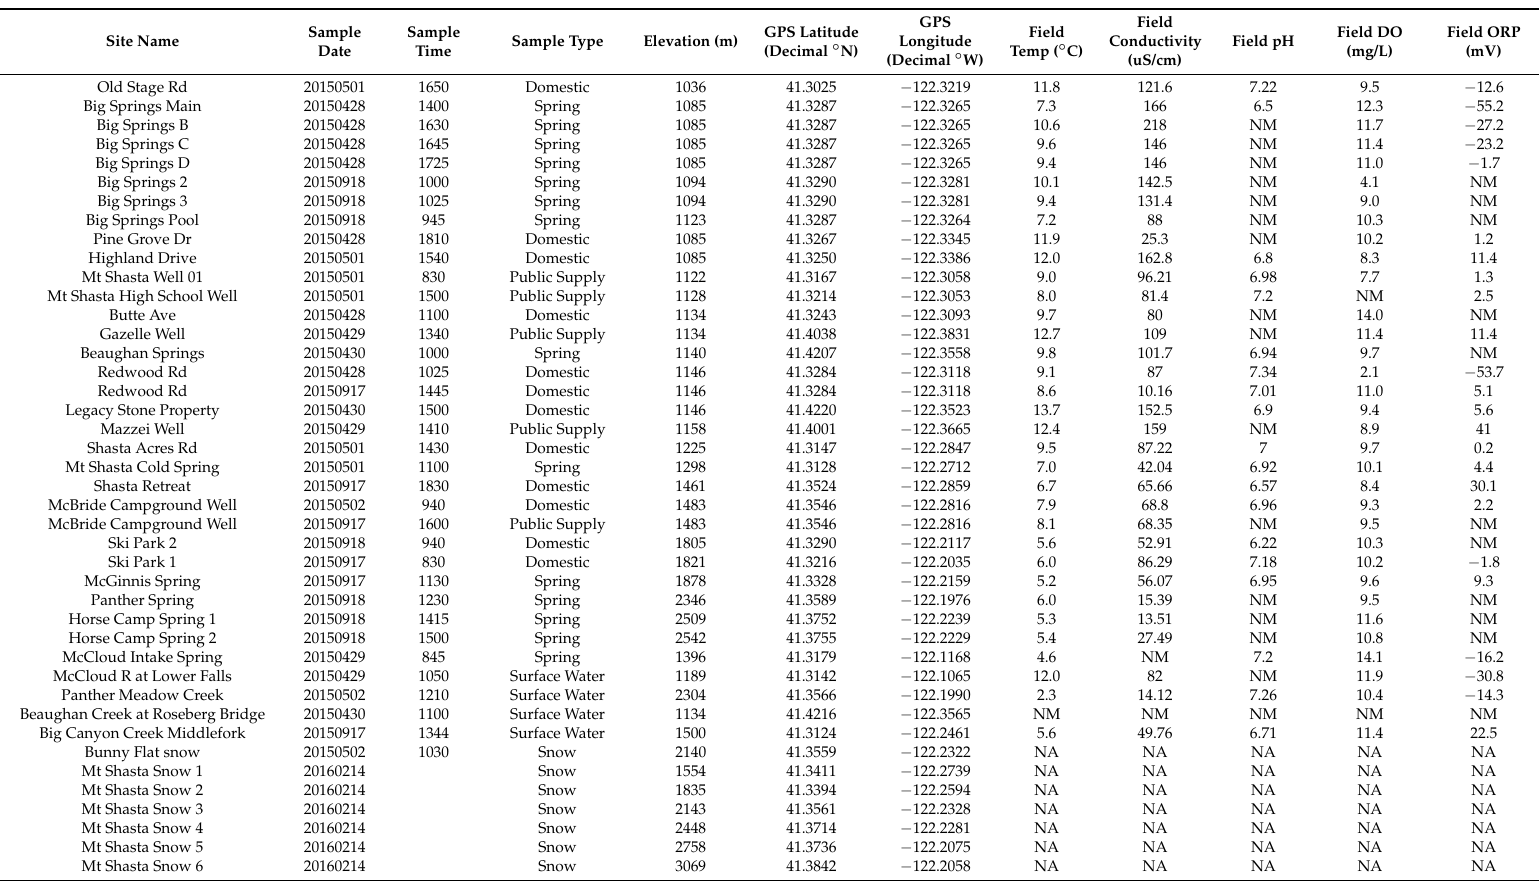
Table A1. Field Parameters (NM = Not Measured; NA = Not